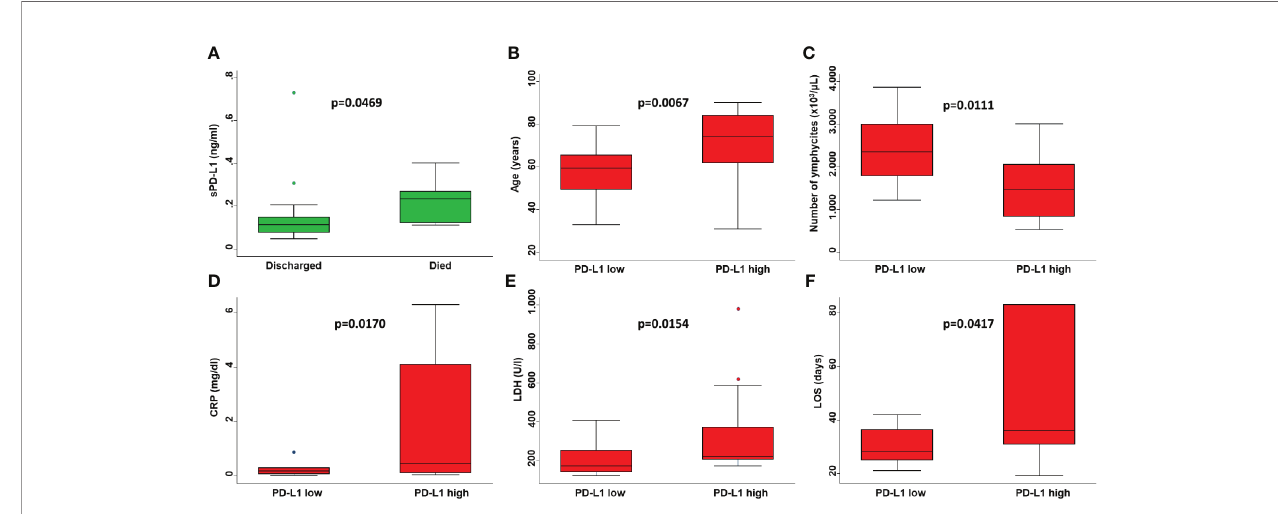
FIGURE 3 | Prognostic value of sPD-L1 in COVID-19 patients. (A) Serum levels of sPD-L1 in COVID-19 patients who died or were discharged from the hospital were compared by Mann-Whitney U test. Age of patients (B) , number of lymphocytes (C) , levels of CRP (D) , levels of LDH (E) and LOS (F) grouped based on sPD- L1 levels were compared using the Mann-Whitney U test. On each box, the central mark is the median, the edges of the box are the 25th and 75th percentiles, the whiskers extend to the most extreme data points not considered outliers, and outliers are plotted individually. p was considered signi fi cant if <